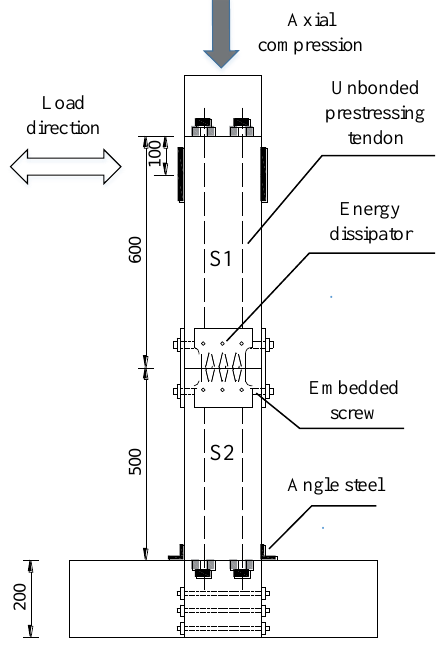
Figure 2. Structure of CFST pier test piece assembled in segments.